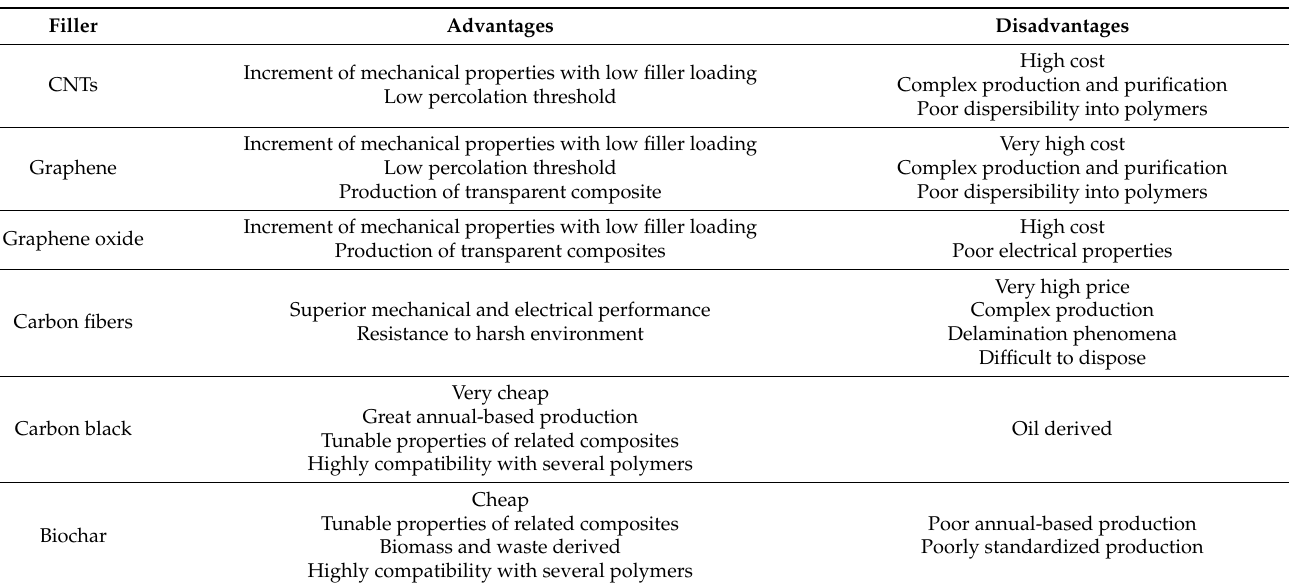
Table 1. A brief overview of the main advantages and disadvantages related to composite production using carbonaceous